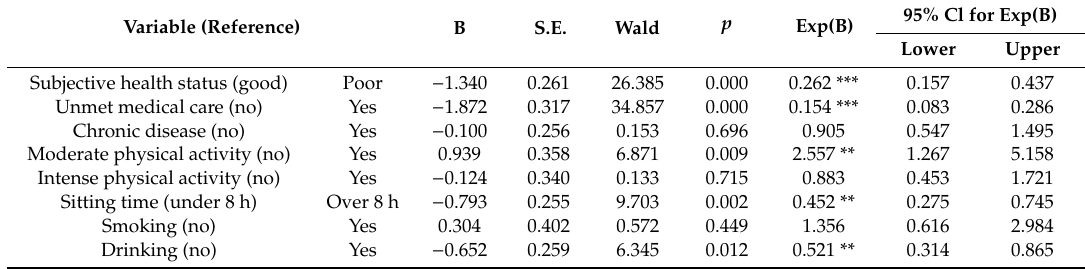
Table 3. Factors a ff ecting health-related quality of life (medical related characteristics, health behavior). Variable (Reference) B S.E. Wald p Exp(B)